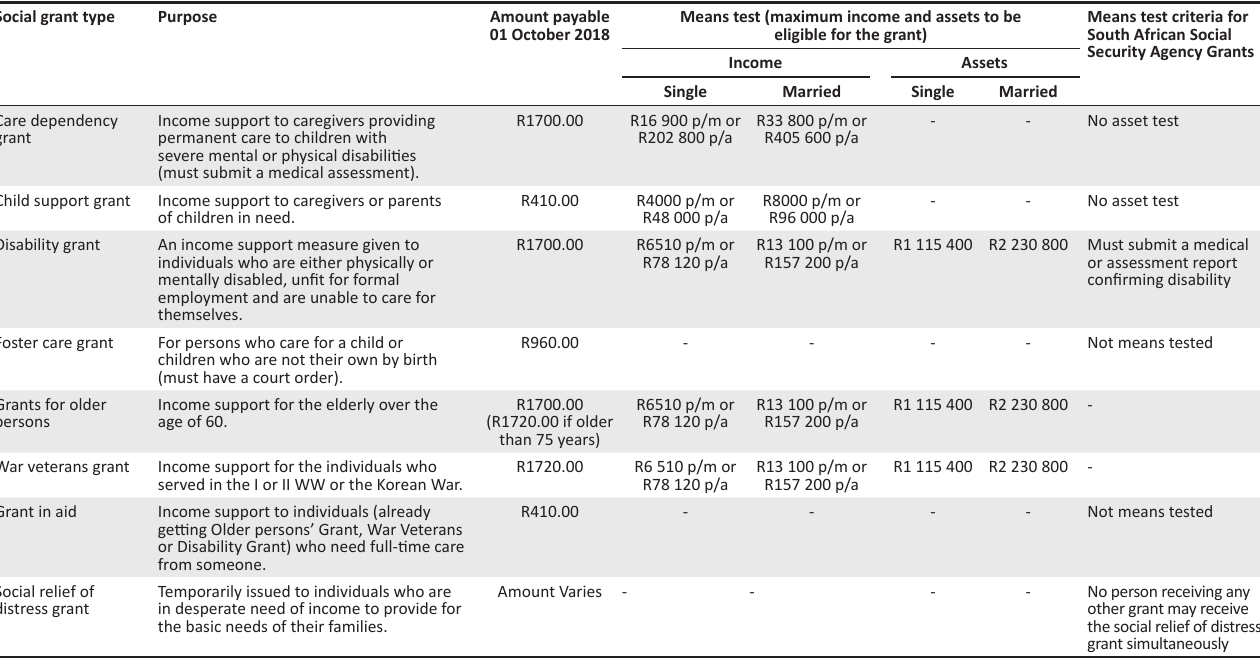
TABLE 1: Type of social grants and means test.